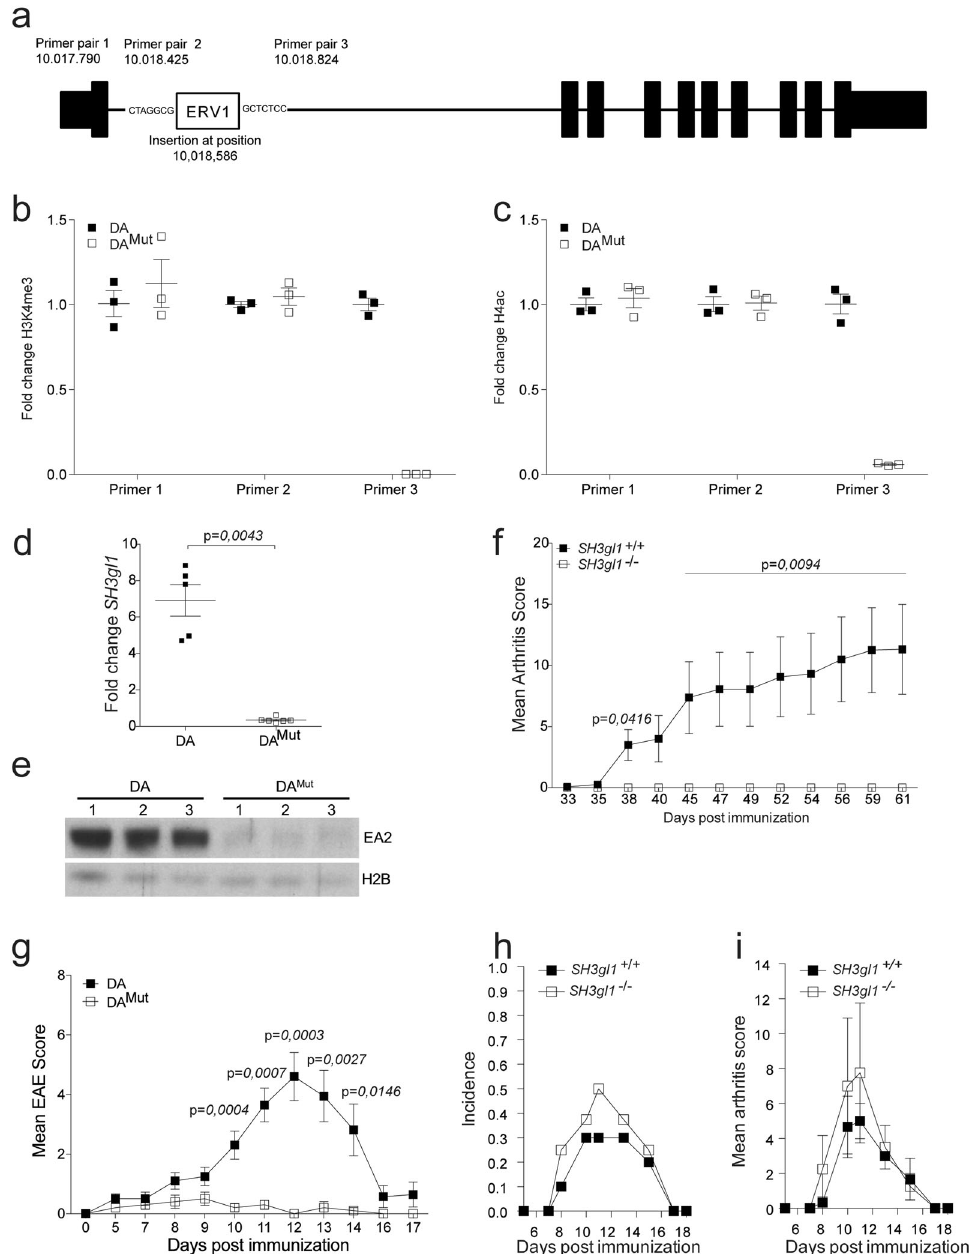
Fig. 2 Endophilin A2 de fi ciency protects against autoimmunity in rodents. a Schematic picture of the SH3gl1 gene with the location of the inserted ERVI long-term repeat element and location of the primer pairs used for quanti fi cation of the H3K4me3 and H4Ac levels. b Fold change of H3K4me3 levels in 3 DA and 3 DA Mut naïve aged matched rats before (Primer pair 1 and 2) and after (Primer pair 3) the insertion in the SH3gl1 gene. c Fold change of H4Ac levels in 3 DA and 3 DA Mut naïve aged matched rats before (Primer pair 1 and 2) and after (Primer pair 3) the insertion in the SH3gl1 gene. d Fold change of the SH3gl1 gene expression in PBMCs from 5 DA and 6 DA Mut naïve aged matched rats. Relative fold change calculated to one DA Mut reference sample. e Western blot analysis of the expression of the Endophilin A2 protein in brain samples of three DA and DA Mut rats. Histone 2B was used as loading control. f Mean arthritis score after collagen-induced arthritis in 9 SH3gl1 knockouts and 16 wild-type littermates. Arthritis data has been reproduced twice with the same results. g Mean EAE score after spinal cord homogenate induced EAE in 10 DA and 10 DA Mut rats. h Incidence of collagen-antibody induced arthritis in 10 SH3gl1 − / − and 10 SH3gl1 + / + wild-type littermates. i Mean arthritis score of sick mice from above experiment after collagen-antibody induced arthritis in 4 SH3gl1 knockouts and three wild-type littermates. Non-parametrical Mann – Whitney U test was used for statistical evaluation of data. Data are presented as mean with error bars indicating ±SEM with each dot representing an individual SH3gl1 de fi cient thymocytes developed nearly no arthritis reduction in antigen-speci fi c cells was due to a defect in the (Fig. 3c) and had fewer antigen-speci fi c cells compared to the thymic T cell development, we assessed thymic T cell populations wild-type recipients as determined by an in vitro recall assay by fl ow cytometry. No difference in T cell populations could be using the GPI peptide while no signi fi cant difference could be observed between the SH3gl1 de fi cient mice compared to their seen in mitogen activated cells (Fig. 3d). To determine if this wild-type littermates indicating that the reduced numbers of